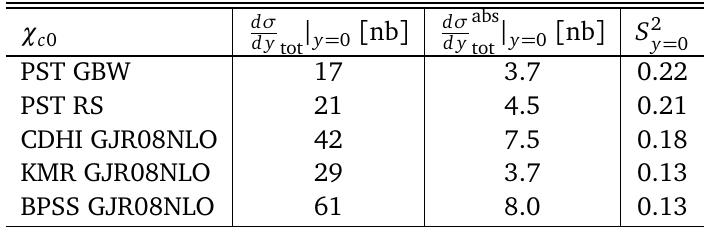
CEP for various prescriptions and UGD choices. c 0